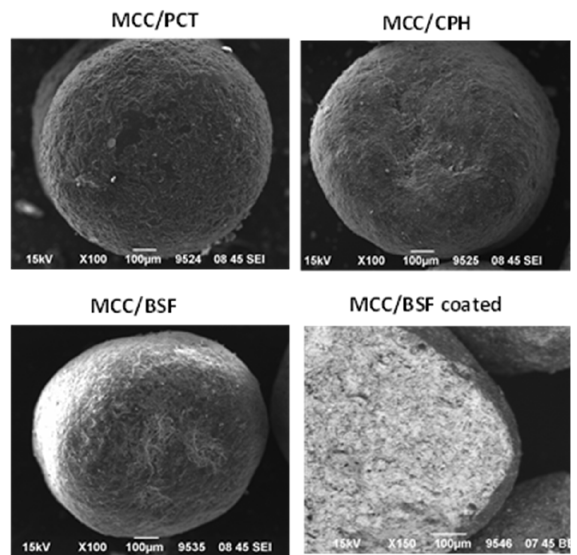
Figure 1. Images of plain pellets of the three densifiers: paracetamol (MCC/PCR), calcium phosphate hydrate (MCC/CPH), and barium sulphate (MCC/BSF) and a cross section of a coated MCC/BSF pellet where polymeric coating appears as a dark surface layer against a barium‐sulfate‐rich interior.